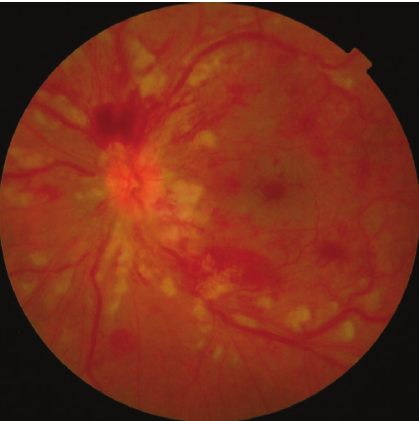
Figure 1: Colour fundus photography of the left eye shows disk edema, sheathing of the retinal vessels, retinal flame-shaped hemorrhages in all four quadrants, cotton wool spots, and dilated retinal veins.